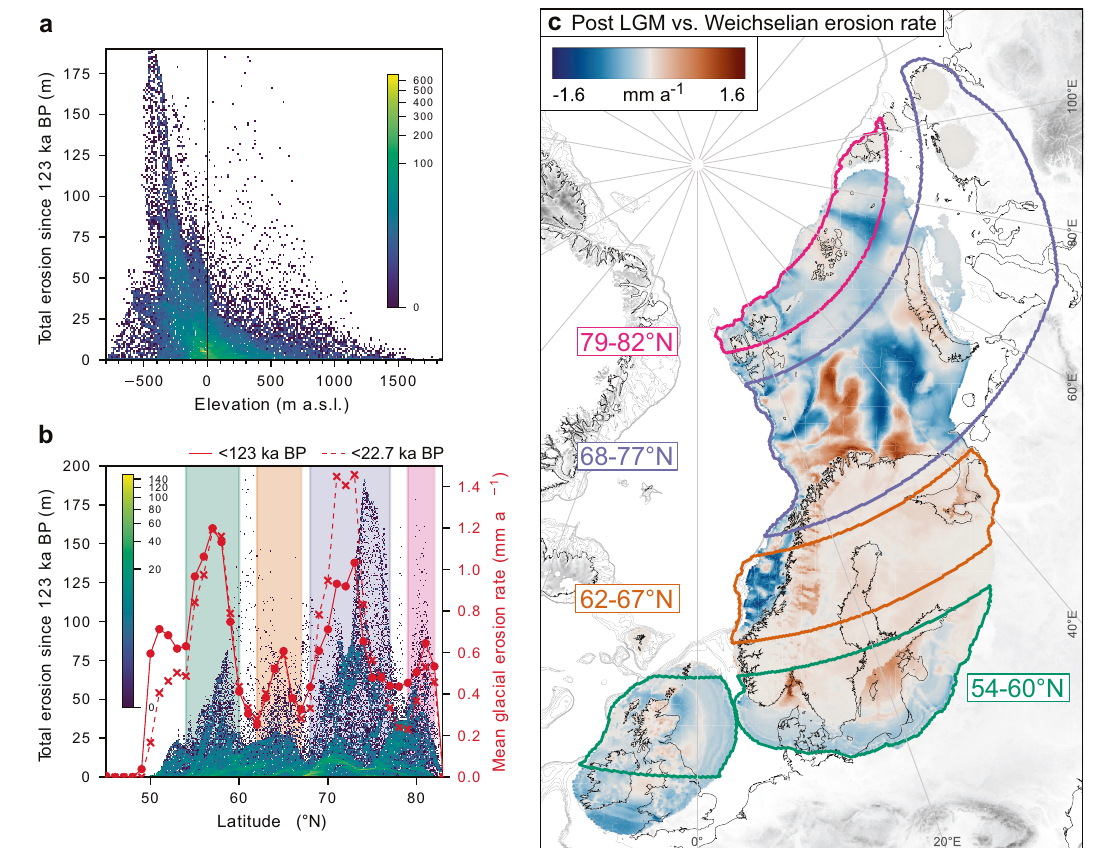
c Changing intensityofglacialerosion duringdeglaciation (<22.7 ka BP) compared to the long-term mean. Positive values indicate increasing rates of erosion during deglaciation, and negative values indicate decreasing erosion